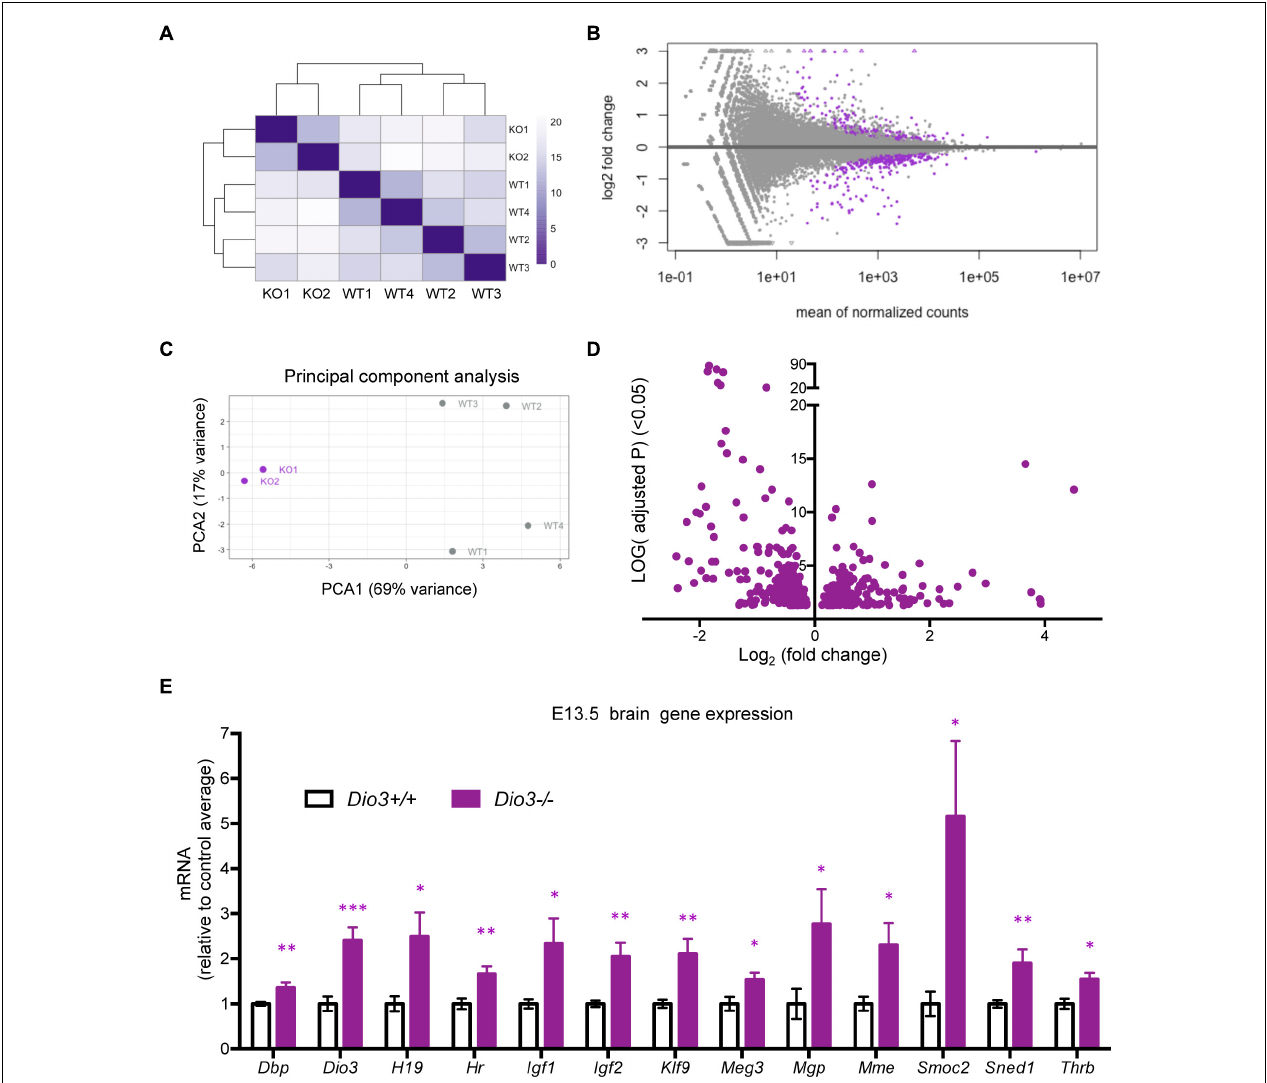
FIGURE 5 | Gene expression profiling of E13.5 Dio3 + / + and Dio3 − / − male brains. (A) Heat map representing the expression and clustering of the RNA samples used. (B–D) MA, PCA, and volcano plots showing 588 DEGs (adjusted P < 0.05) in purple color. In PCA panel, WT1-4 and KO1-2 represent samples from Dio3 + / + and Dio3 − / − mice. (E) qPCR validation of selected DEGs in an extended number of samples, including females. Data represent the mean ± SEM relative to control mean value of 8 and 6 different samples from E18.5 Dio3 + / + and Dio3 − / − mice. ∗ , ∗∗ , and ∗∗∗ , indicate p < 0.05, p < 0.01, and p < 0.001, respectively, E13.5 vs E18.5 as determined by the Student’s t -test. ( Dio3 − / − mice express Dio3 mRNA, although they carry an inactivation mutation of the coded